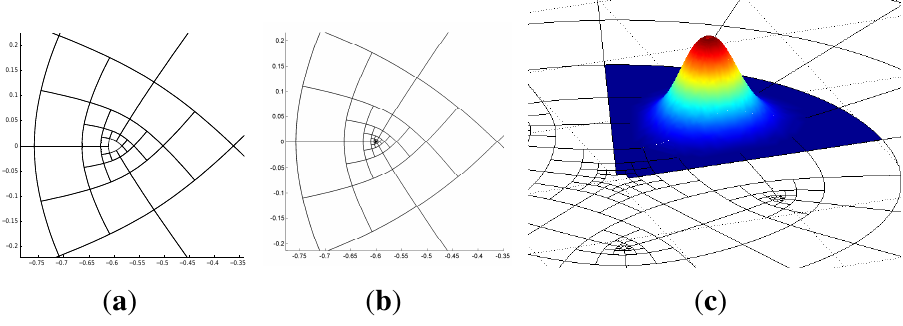
Figure 6. Catmull–Clark elements. ( a ) Refinement Level 3; ( b ) refinement Level 7; ( c ) a Catmull–Clark subdivision function.